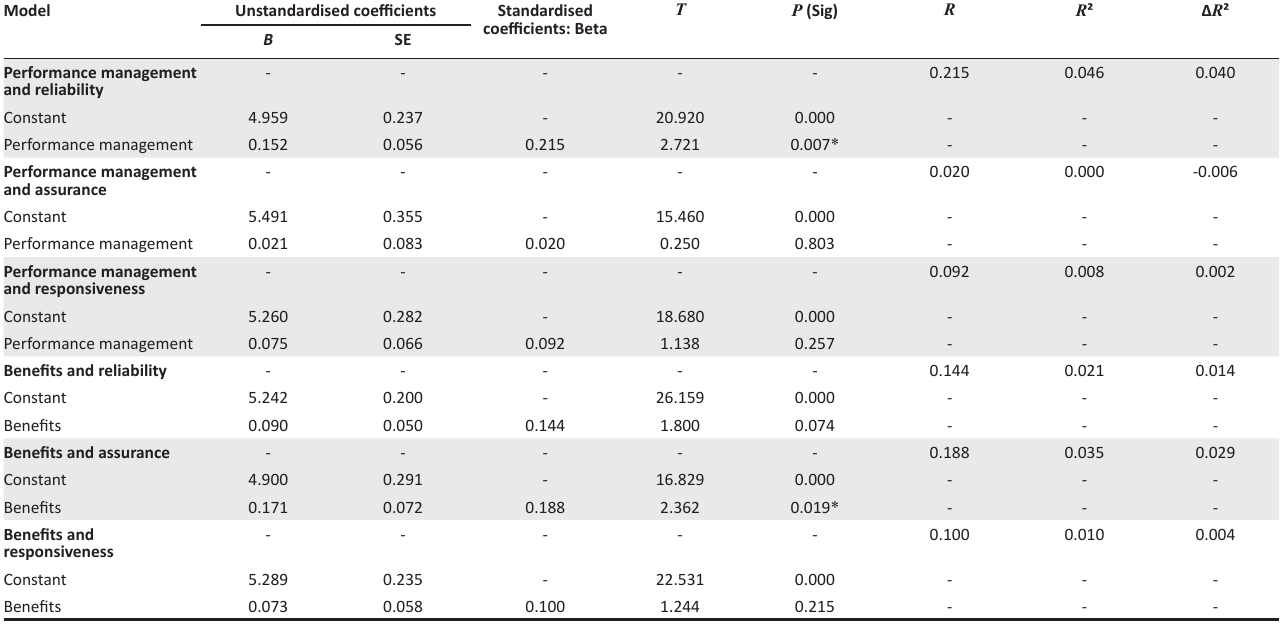
TABLE 3: Regression analyses of rewards and service quality orientation.